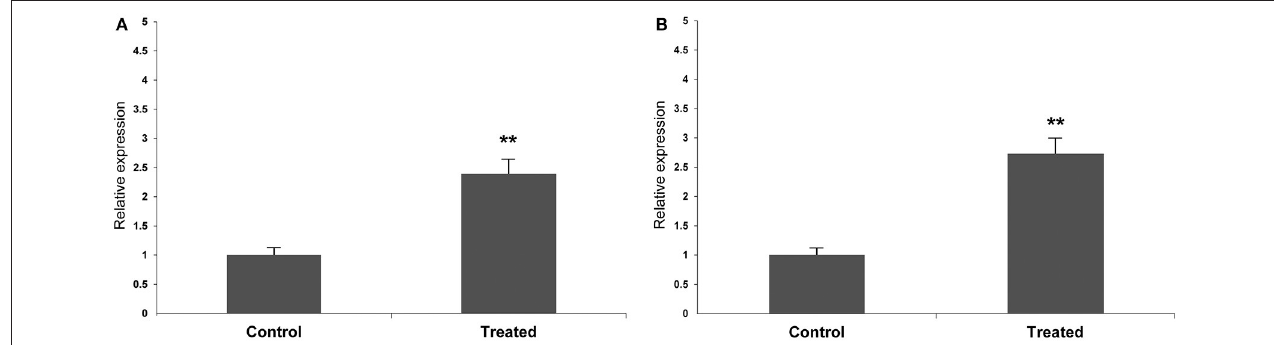
FIGURE 7 | Real-time quantitative PCR (RT-qPCR) expression profile of target genes in M. glaucescens explants before (control) and after (treated) shoot organogenesis induction. (A) WOUND INDUCED DEDIFFERENTIATION 1 (WIND1) . (B) CALMODULIN (CaM) . ** P ≤ 0.05.